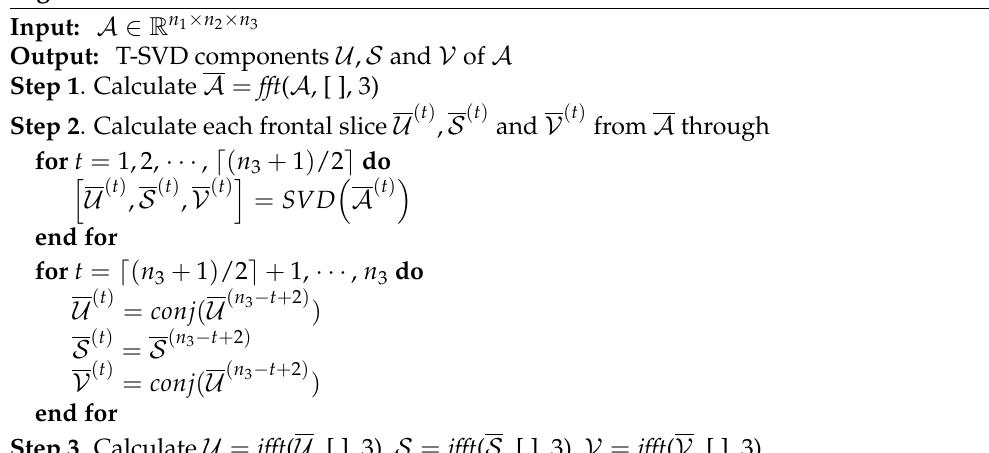
Algorithm A1 T-SVD for a three-order